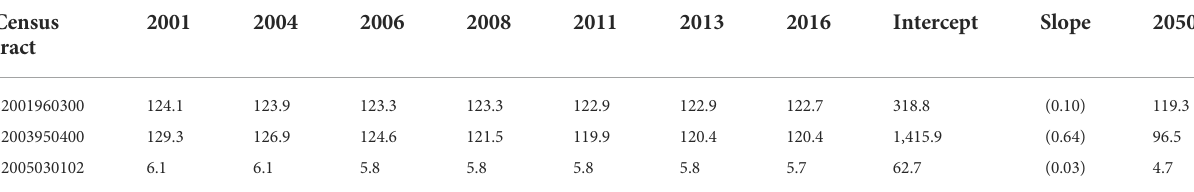
TABLE 6 Examples regression-based projection of crop land cover area (km 2 ) by 2050 by census tract ( CLC k , 2050 ). Census